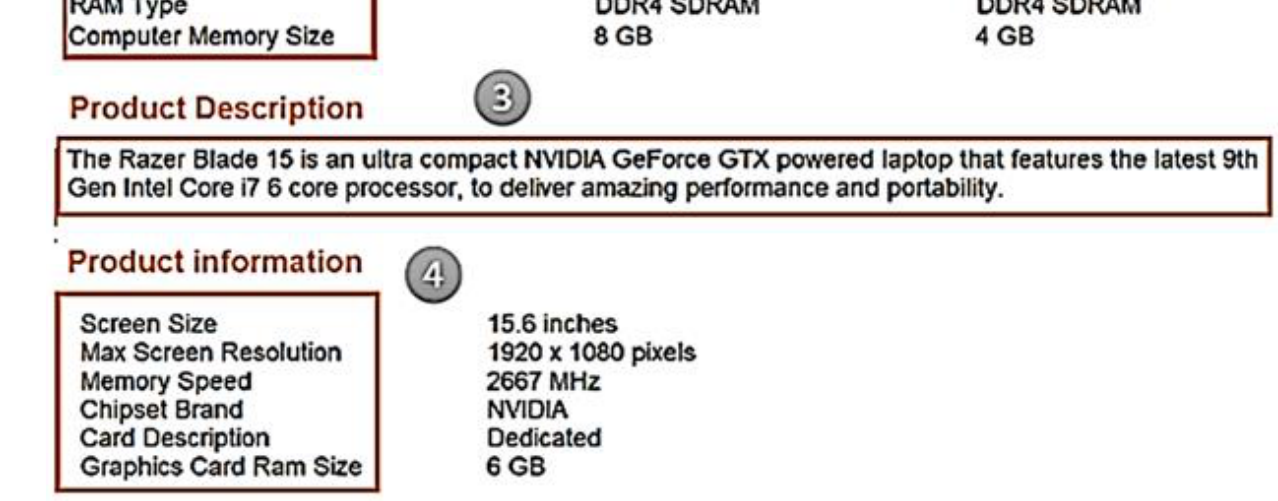
Figure 4. Example product details provided by manufacturers.